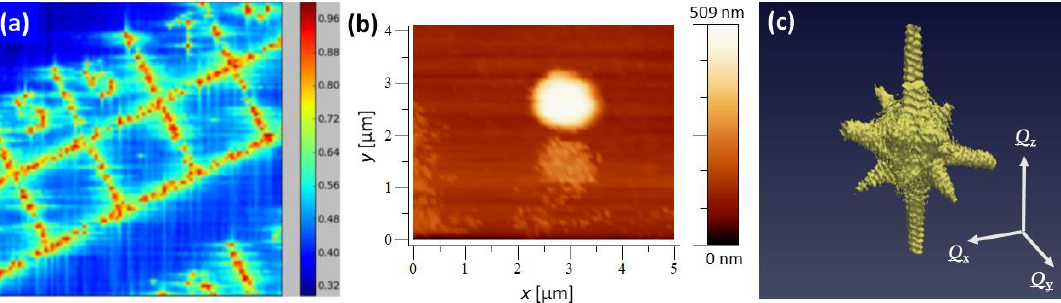
Figure 1. ( a ) Scanning X-ray diffraction map in diffraction contrast at the Au 111 Bragg peak of the patterned samples surface. ( b ) In situ AFM image and ( c ) 3D mw-Bragg coherent X-ray diffraction pattern of a gold crystal.